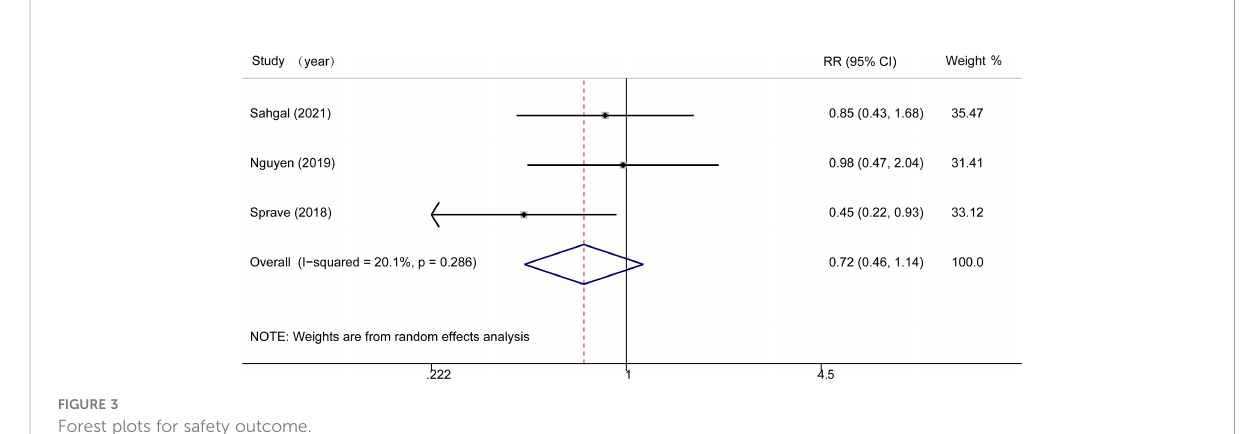
FIGURE 3 Forest plots for safety